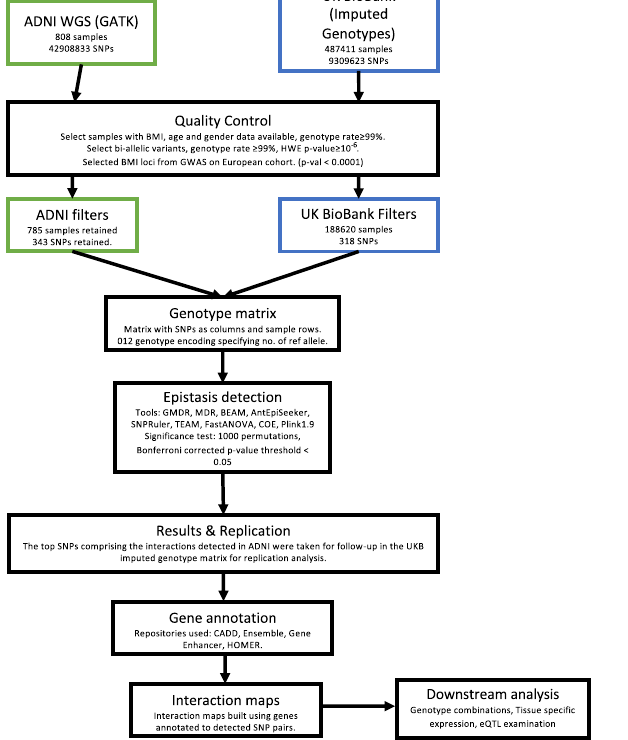
Figure 5. Study workflow. Schematic of procedures followed to detect and validate statistical epistatic